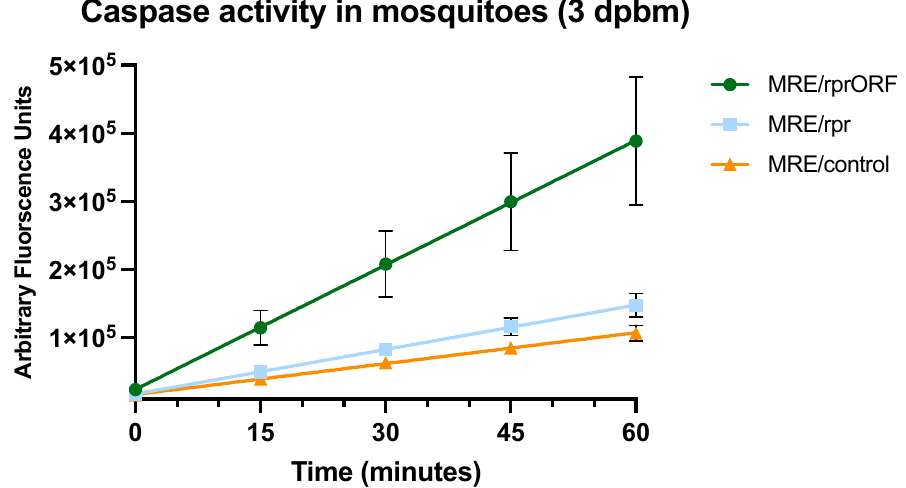
Figure 5. MRE/rprORF causes increased effector caspase activity in Ae. aegypti midgut. Mosquitoes were fed blood containing MRE/rprORF, MRE/rpr, or MRE/control and midguts were dissected after 3 days. Midguts were pooled in groups of eight with three pools/treatment. Each pool thus represents an independent biological replicate. Cells were lysed by sonication and the supernatant was used for caspase assay. Cleavage of the Ac-DEVD-AFC substrate was monitored every 15 min for 1 h. Viral treatment was judged to significantly contribute to variation using two-way ANOVA ( p = 0.0055). The data were plotted using simple linear regression. Error bars indicate SEM.